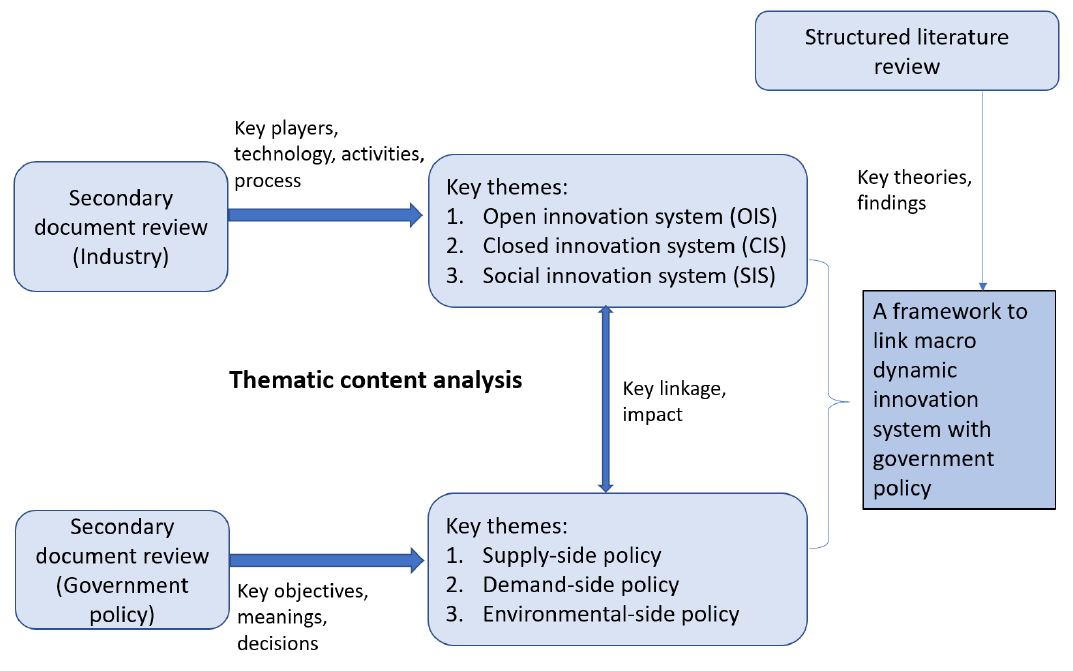
Figure 1. Research design.